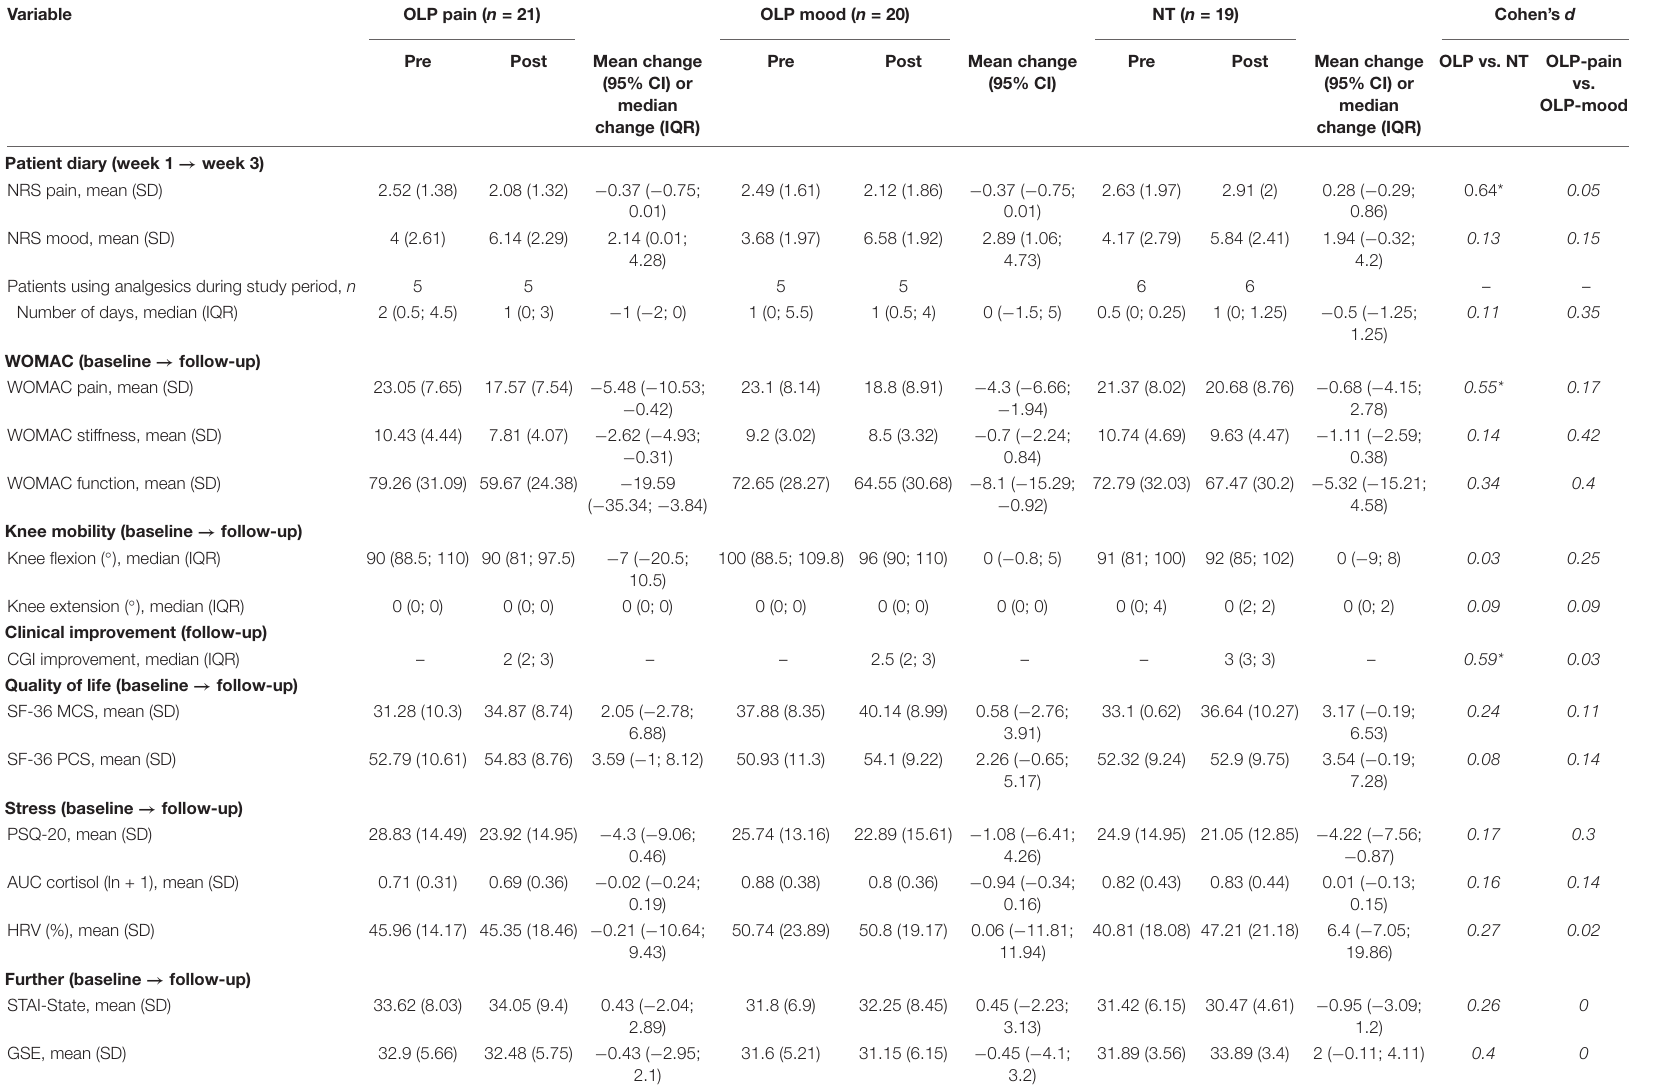
OLP, open-label placebo; NT, no treatment; NRS, Numeric Rating Scale; SD, standard deviation; md, median; WOMAC, Western Ontario and McMaster Universities Osteoarthritis Index; CGI, clinical global impression; SF, short form health survey; MCS, mental component score; PCS, physical component score; PSQ, perceived stress questionnaire; AUC, area under the curve; HRV, heart rate variability; STAI, State-Trait-Anxiety Inventory; HR, heart rate; GSE, General Self-Efficacy. *p <